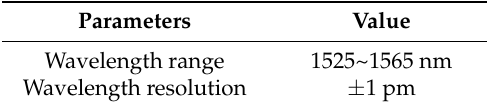
Table 3. Parameters of FBG demodulator.